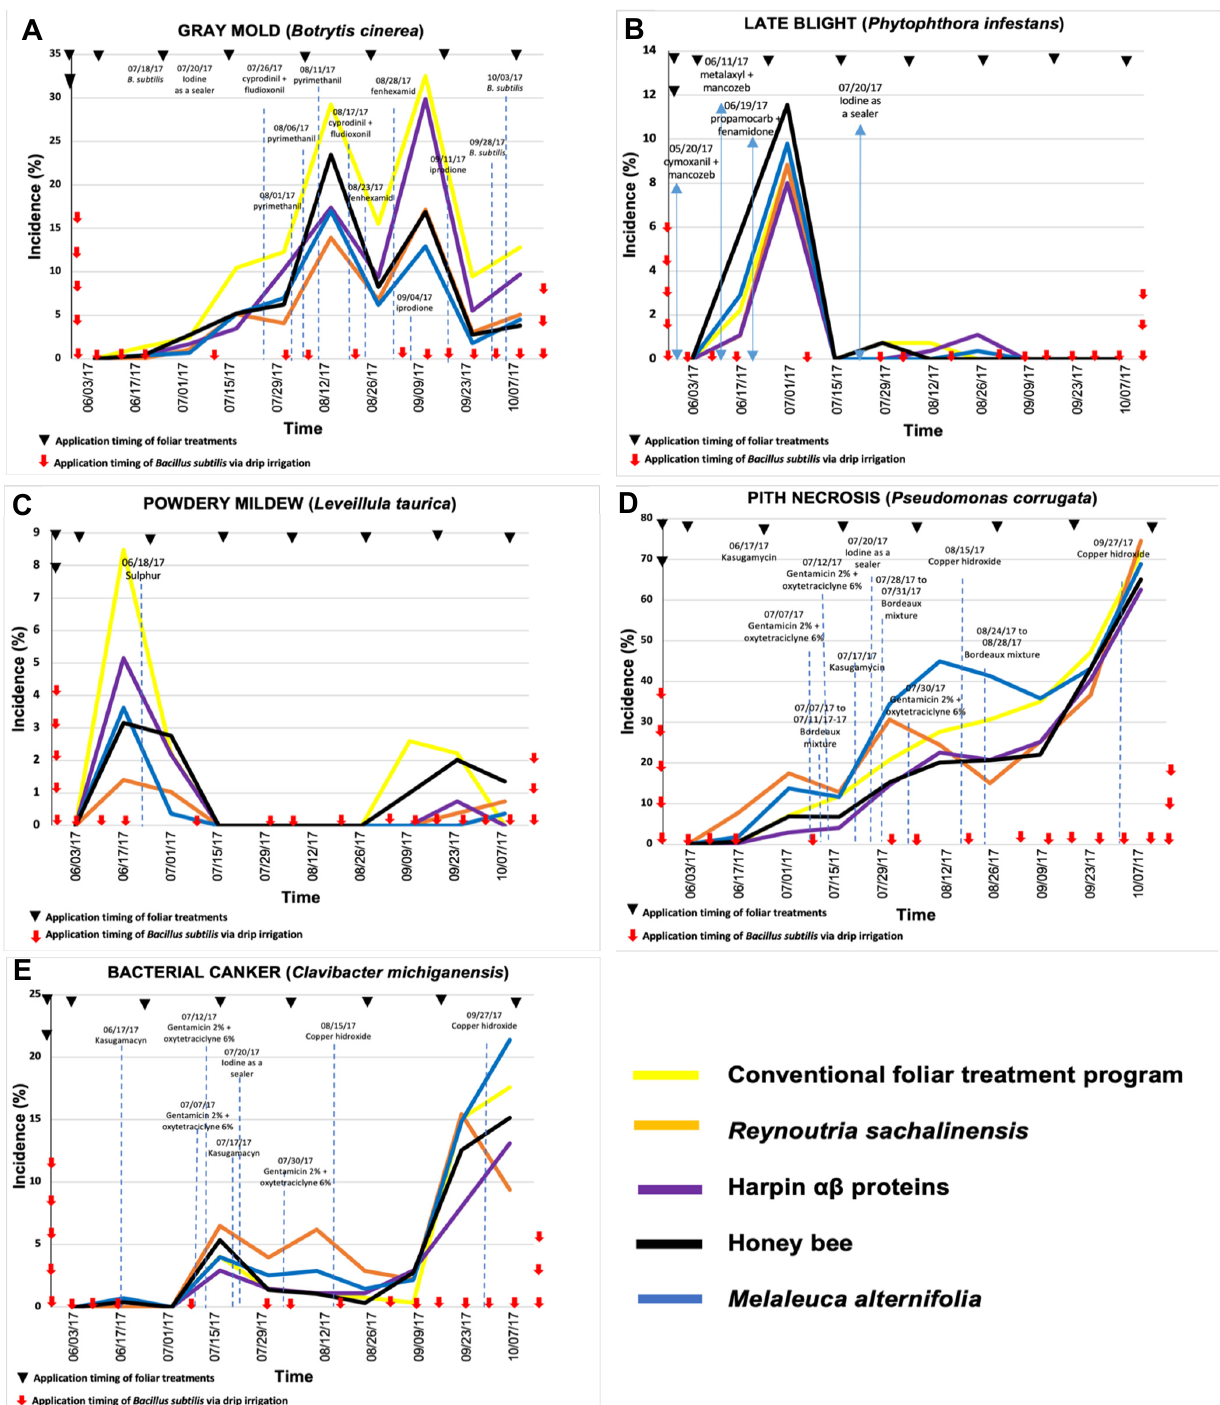
Figure 4. Temporal progress of major tomato diseases—( A ) gray mold ( Botrytis cinerea ), ( B ) late blight ( Phytophthora infestans ), ( C ) powdery mildew ( Leveillula taurica ), ( D ) pith necrosis ( Pseudomonas corrugata ), and ( E ) bacterial canker ( Clavibacter michiganensis )—in five different treatment combinations consisting of soil application of Bacillus subtilis via drip irrigation and foliar application of biorational products in tomato greenhouse production in Experiment 2 in 2017. Dotted vertical lines in graphs indicate the approximate timing of application of fungicides in the conventional management program or in any other treatment due to low-intensity tolerance to disease. Incidence values are the average of three replications.